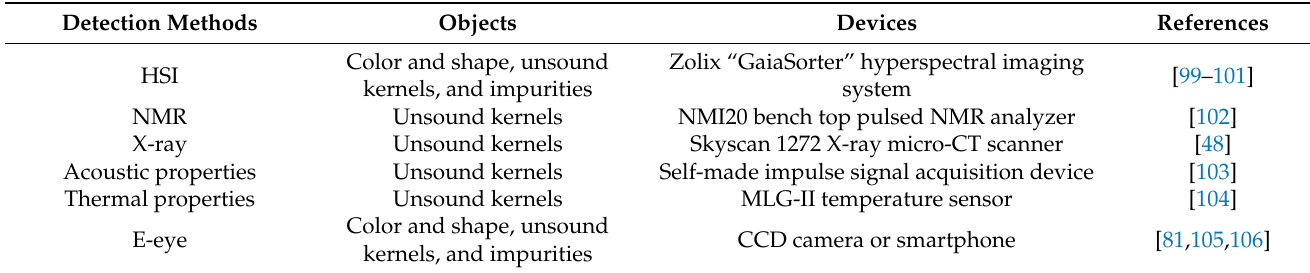
Table 2. Non-destructive quality detection methods for appearance attributes of cereal